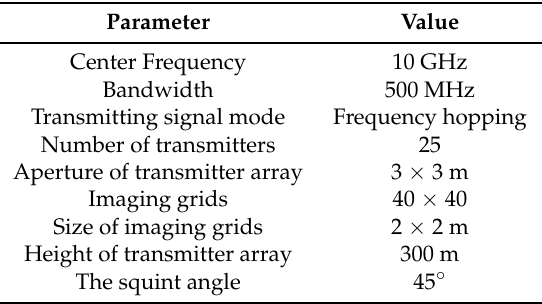
Table 1. System parameters.